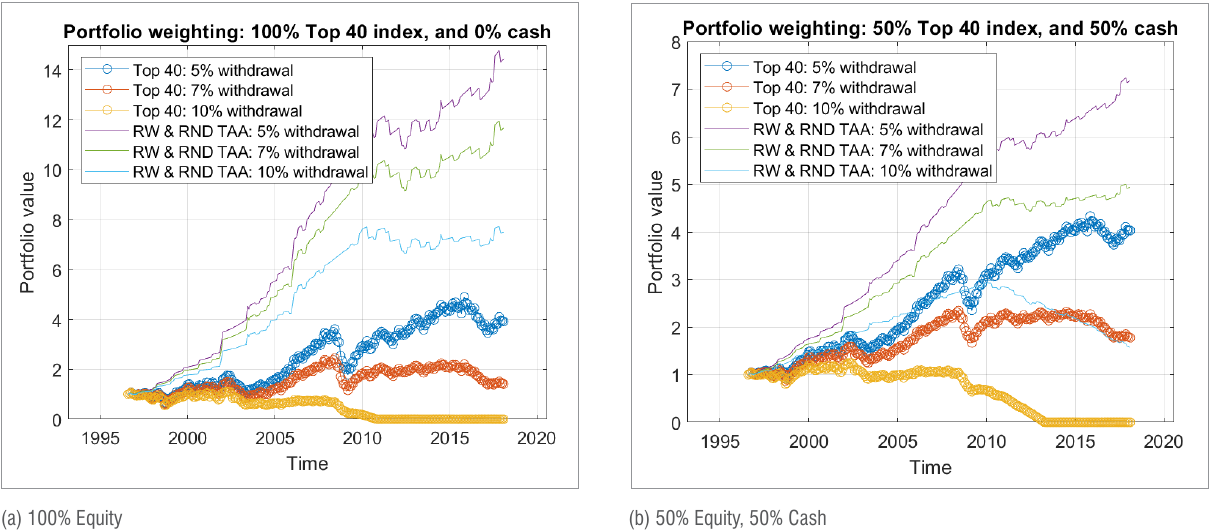
Figure 4: The accumulated portfolio value for a fixed asset allocation vs the real-world and risk-neutral tactical asset allocation (RW & RND TAA) framework with withdrawal rates of {5%, 7%, 10%} returns.